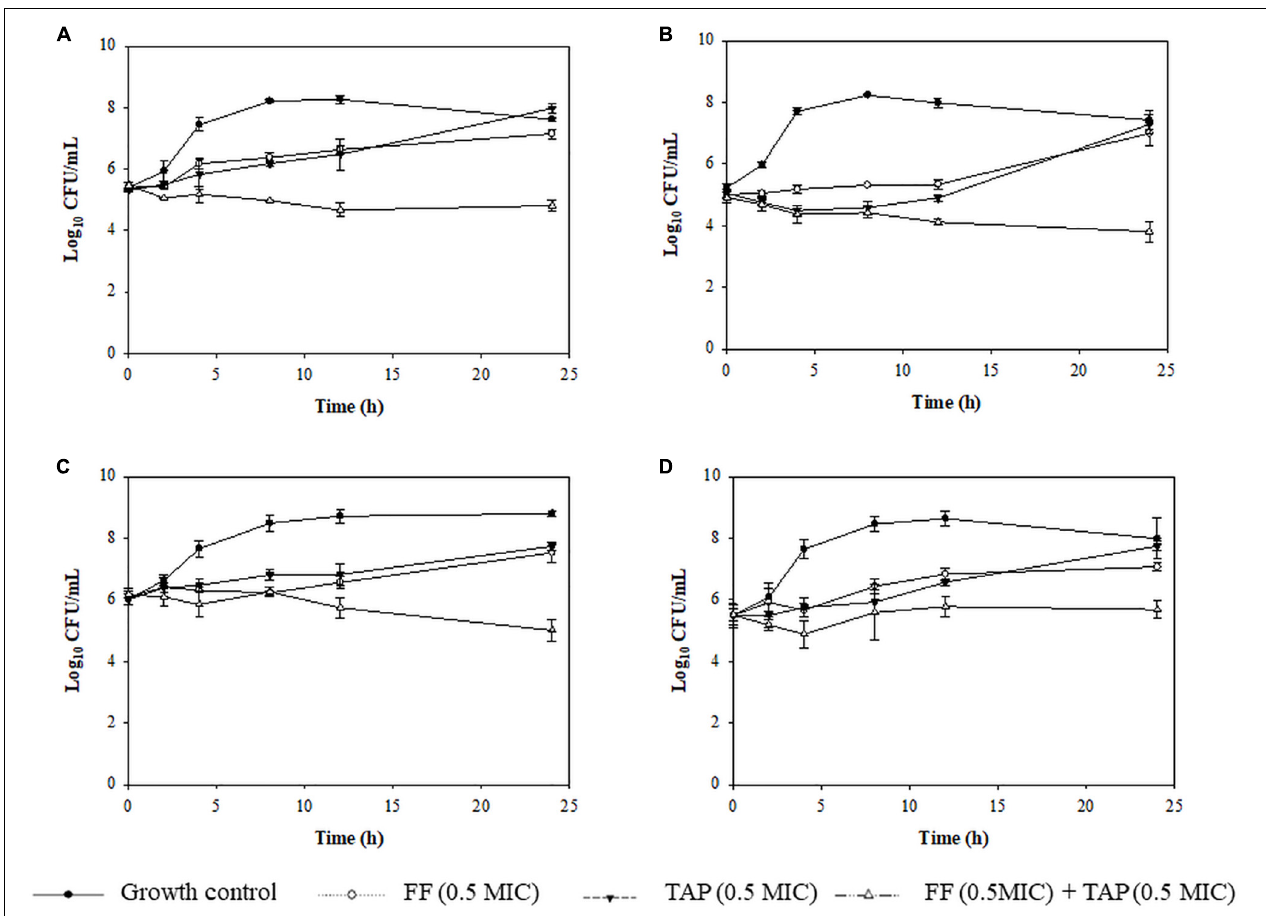
FIGURE 2 | Time-kill assay showing the killing kinetic of FF, TAP alone and in combination against 4 isolates of intermediate (B) or resistant (A,C,D) A. pleuropneumoniae to FF (A) No.30 (FICI = 0.1875), (B) No. 25 (FICI = 0.625), (C) No. 42 (FICI = 0.75), and (D) No. 50 (FICI = 1) which served as the negative control. Refer to Table 2 for strain details. Results show the mean ± the standard error of the mean (SEM) from three independent